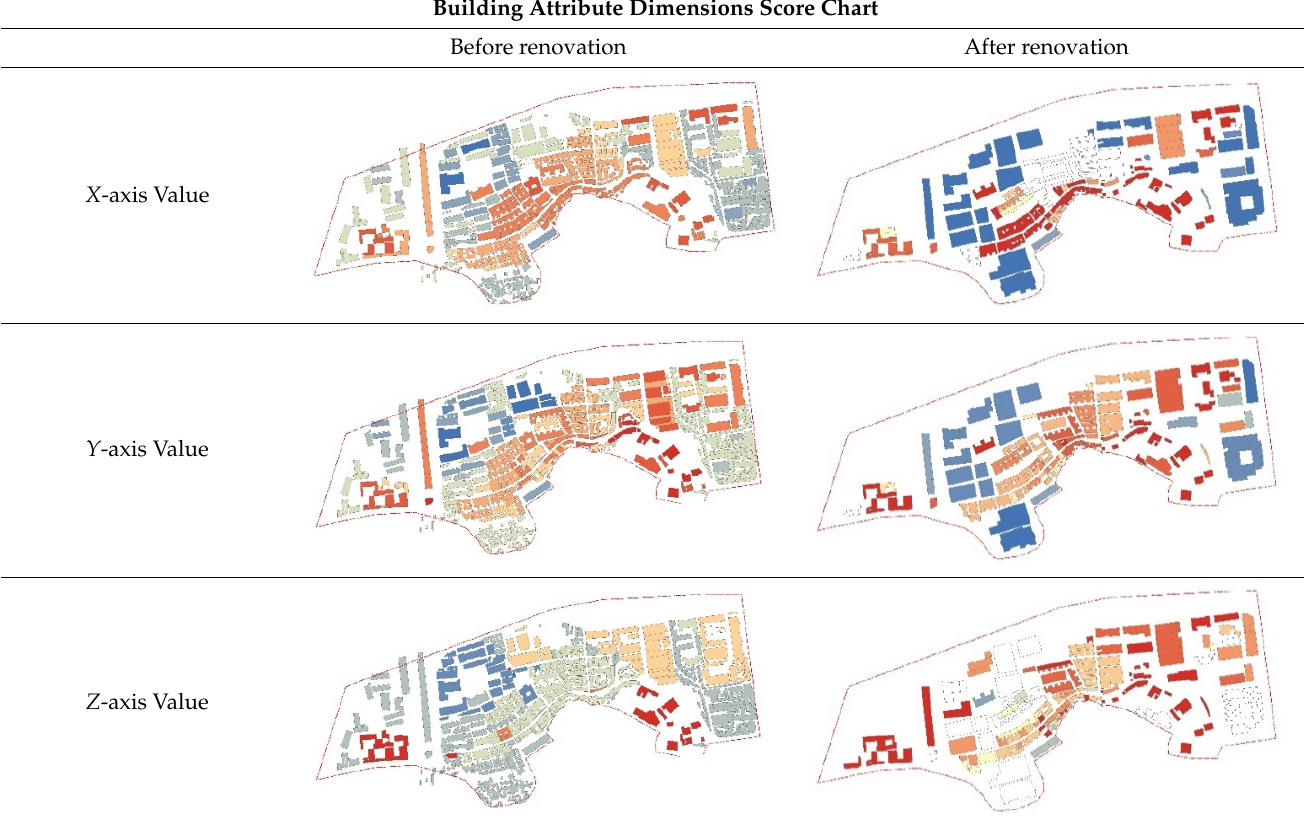
Table 2. Building attribute dimensions score chart.